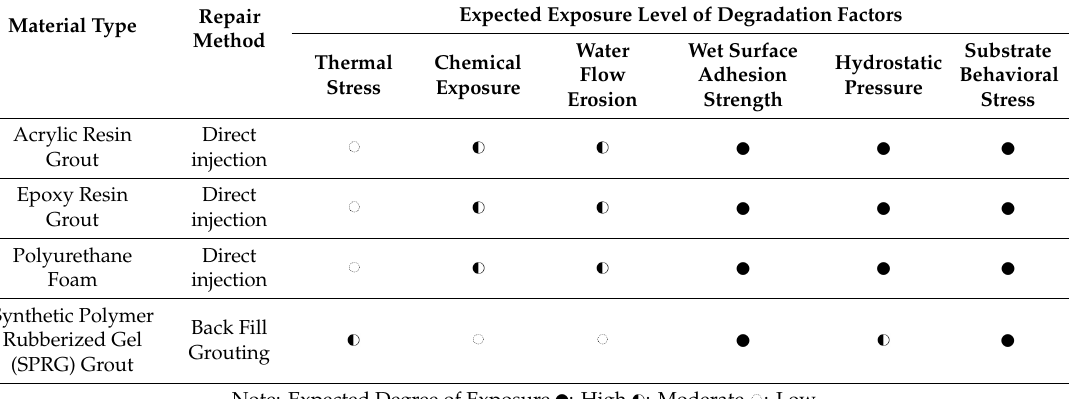
Table 1. The expected degree of exposure to degradation factors in accordance to grout-injection material repair methods in leakage cracks (analytic hierarchy process (AHP) statistics data in Korea).